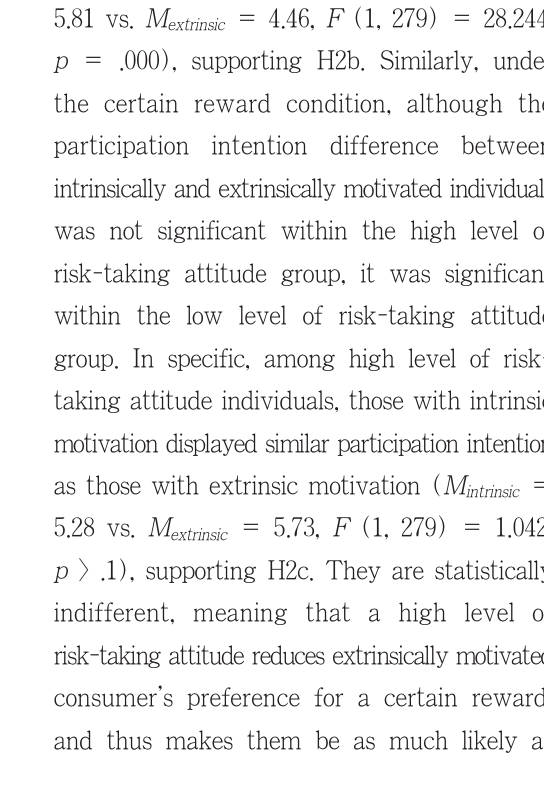
<Figure 3> Three-way Interaction Effect among Reward Uncertainty, Motivation Type